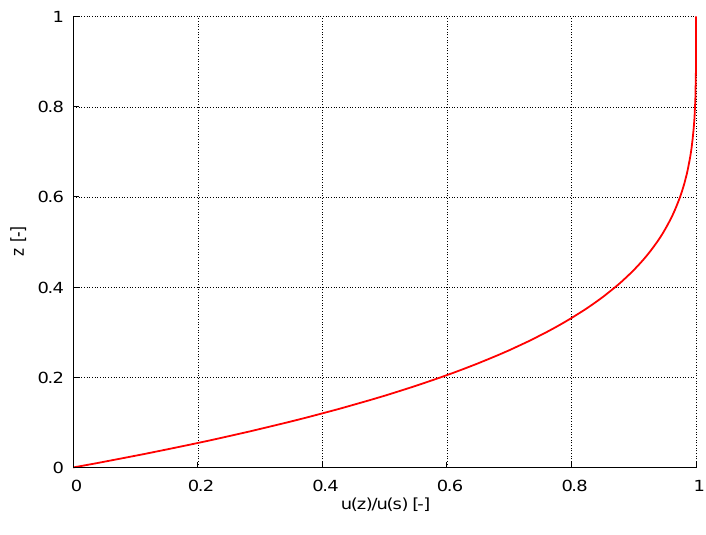
Fig. 1. 2-D flowline steady-state manufactured solution (coefficient λ = 4): horizontal component of velocity scaled to the surface velocity as a function of dimensionless thickness. Horizontal velocity increases with the fourth power of ice thickness. Most shearing ice concentrated near the glacier base which is similar to lamellar